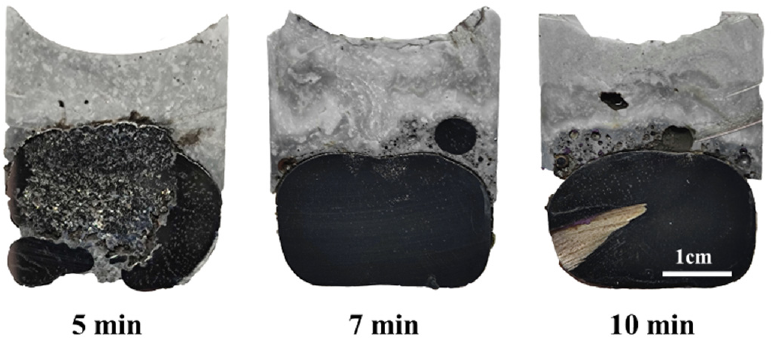
Figure 11. The interfacial morphology during the reaction of Fe-13Mn-5Al alloy and low SiO 2 mold flux.